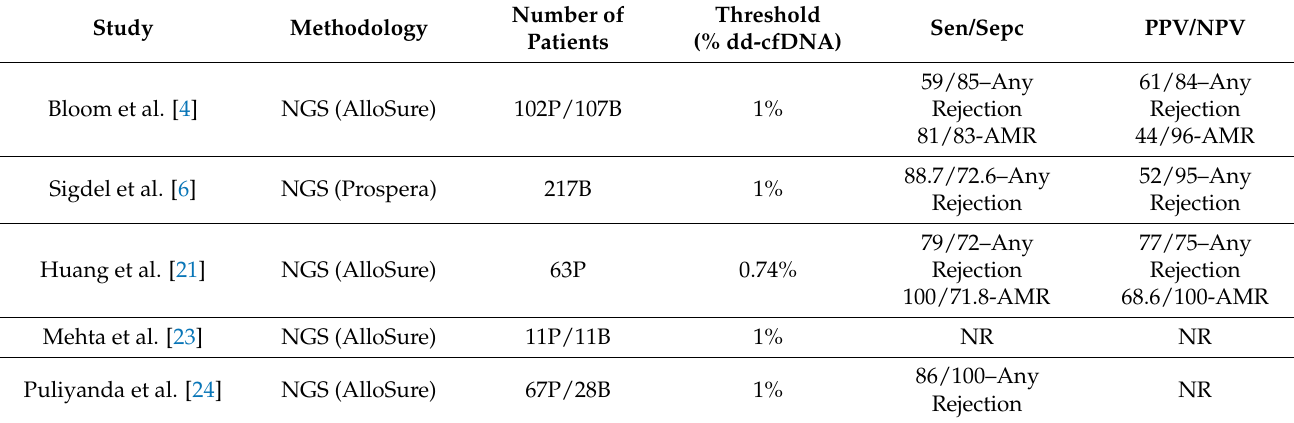
Table 1. Studies assessing ddcf-DNA in plasma for the diagnosis of acute rejection using commercially available assays. Study